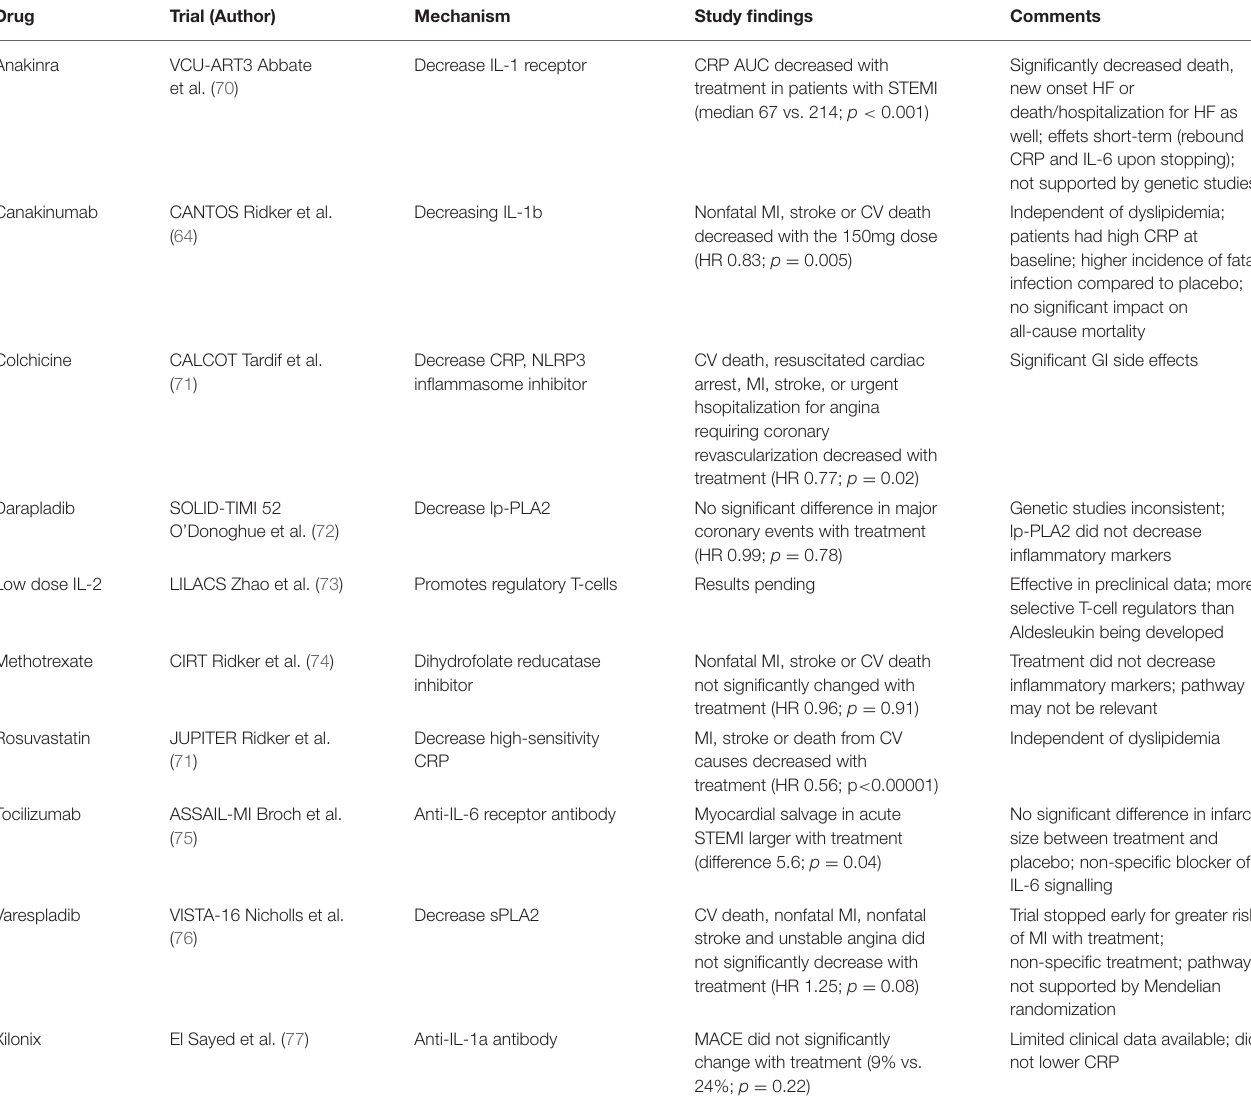
TABLE 2 | Pharmacologic therapies for CVD targeting inflammatory pathway.